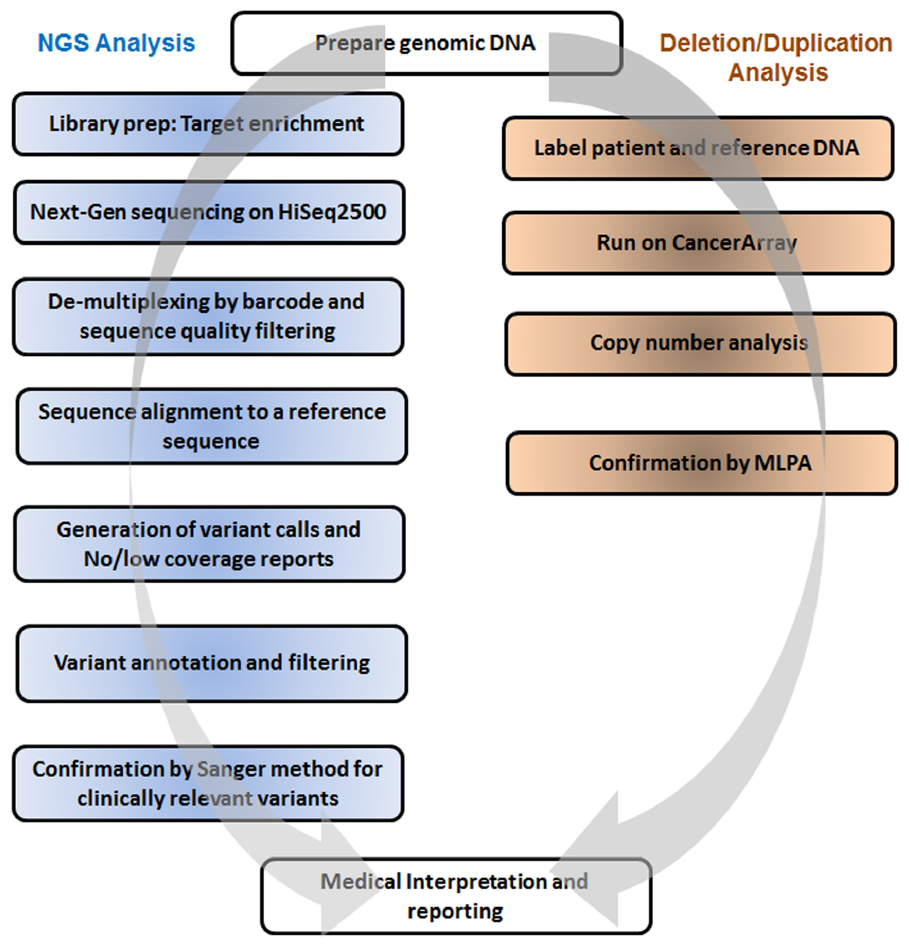
Figure 1. Schematic diagram of BRCAplus assay workflow.